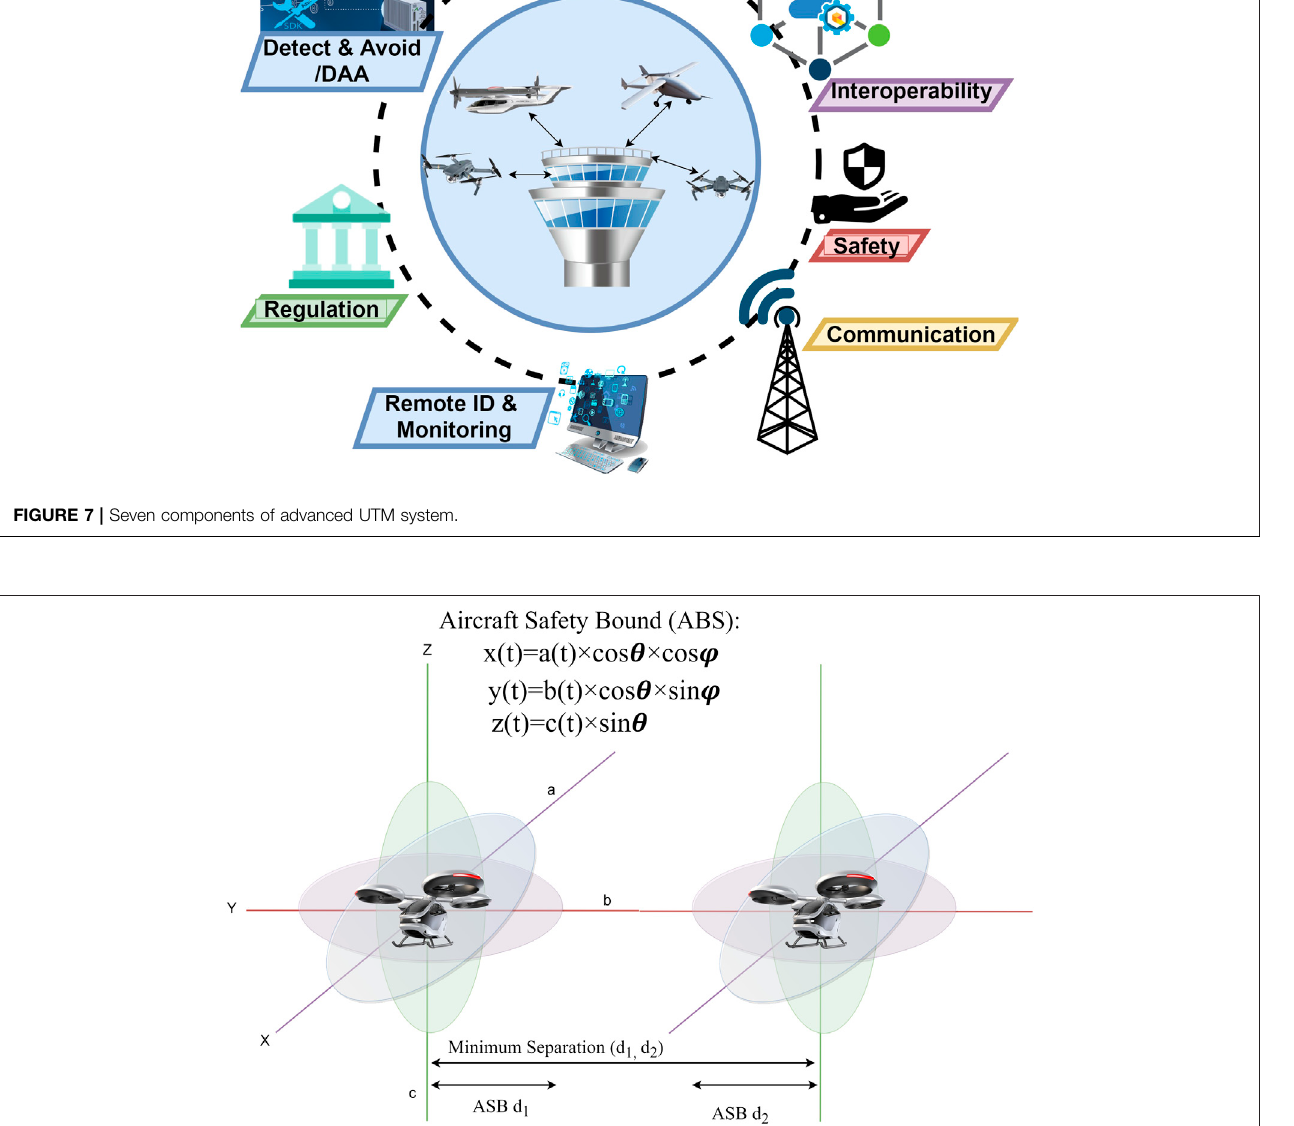
FIGURE 8 | ABS and relative separation distance between